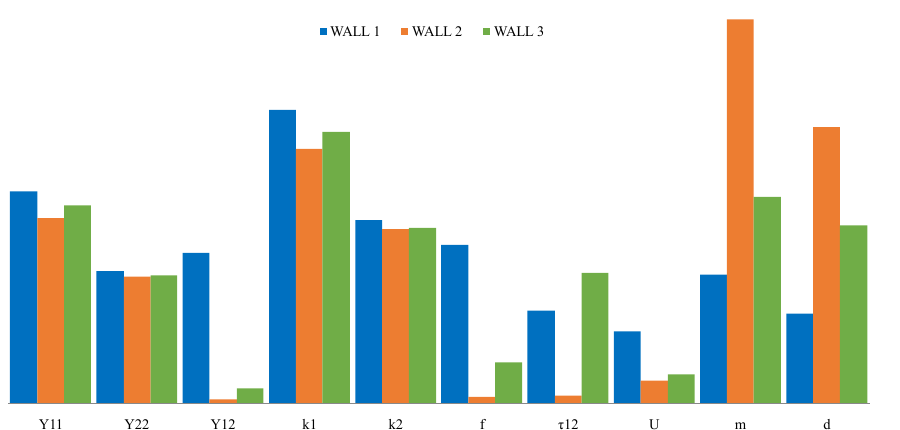
Figure 7. Comparative diagram of dynamic characteristics of all the external walls of the venti- lated façade.